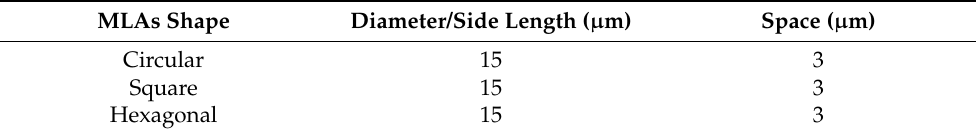
Table 1. The detailed parameters of these MLAs mask.